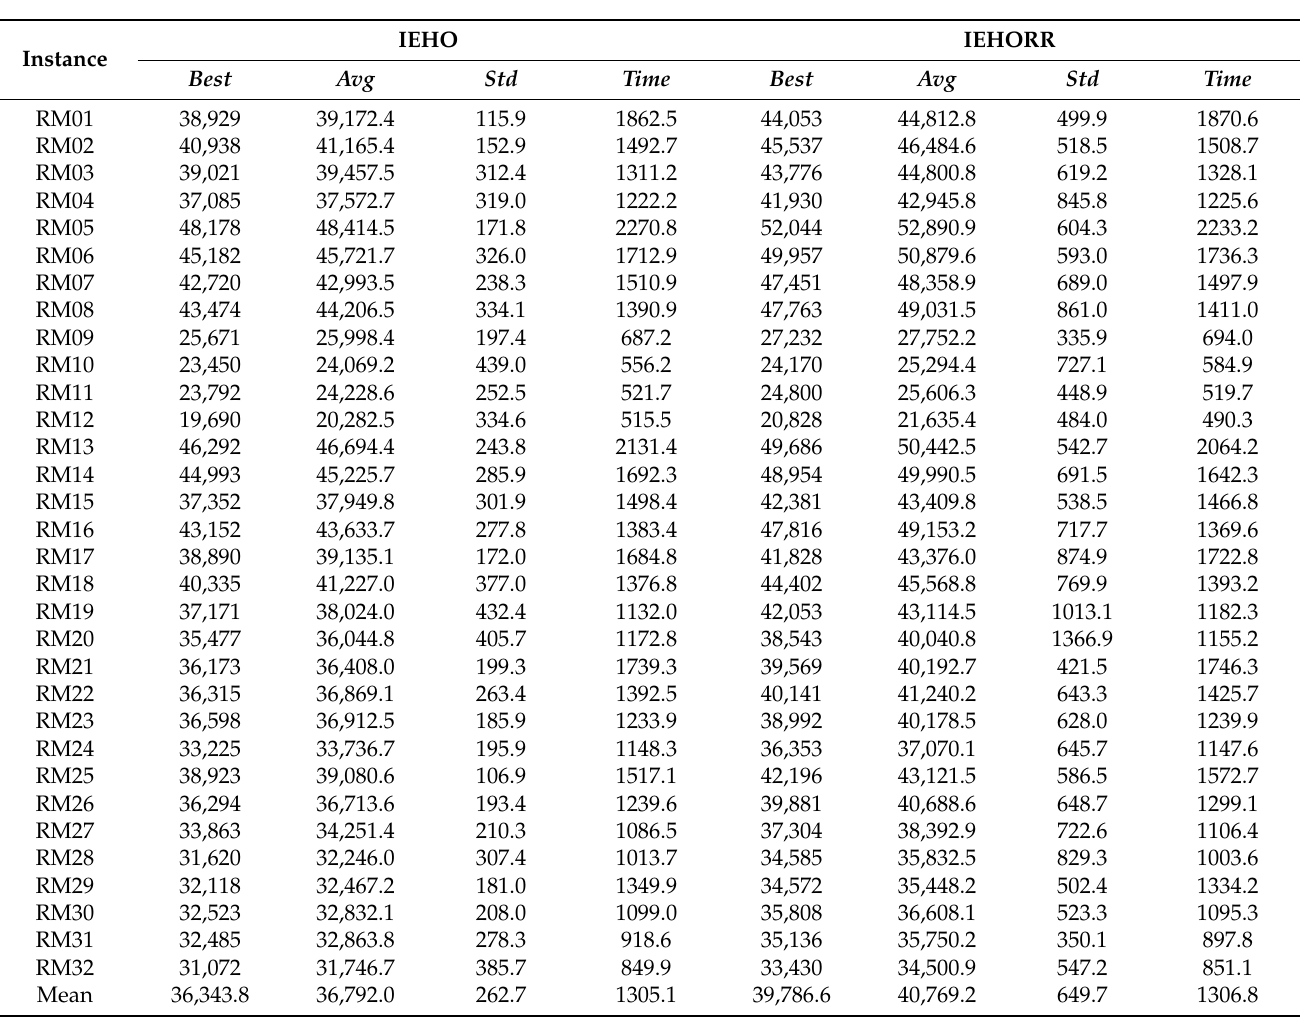
Table 6. Comparison results of IEHO and